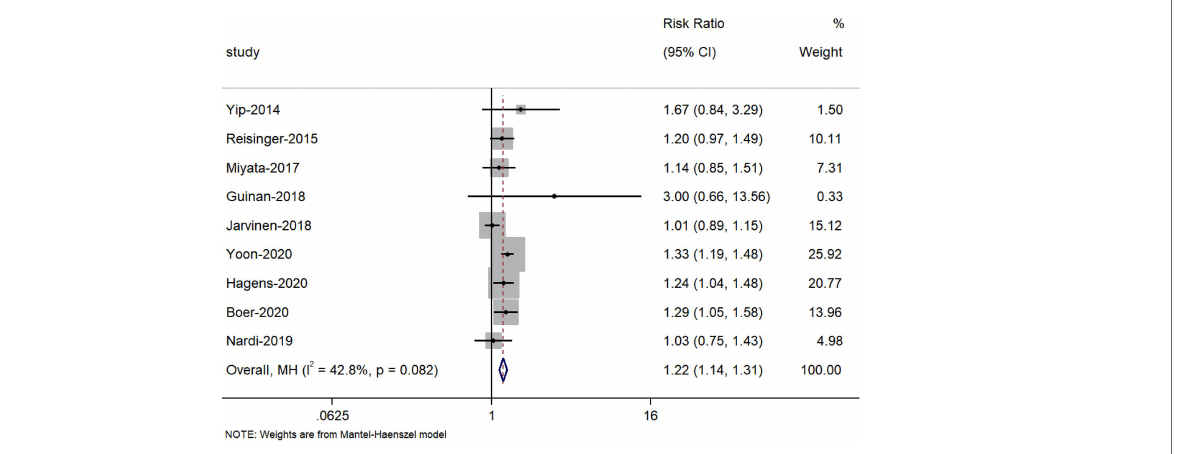
FIGURE 2 | Forest plots of the prevalence of sarcopenia before and after neoadjuvant therapy.